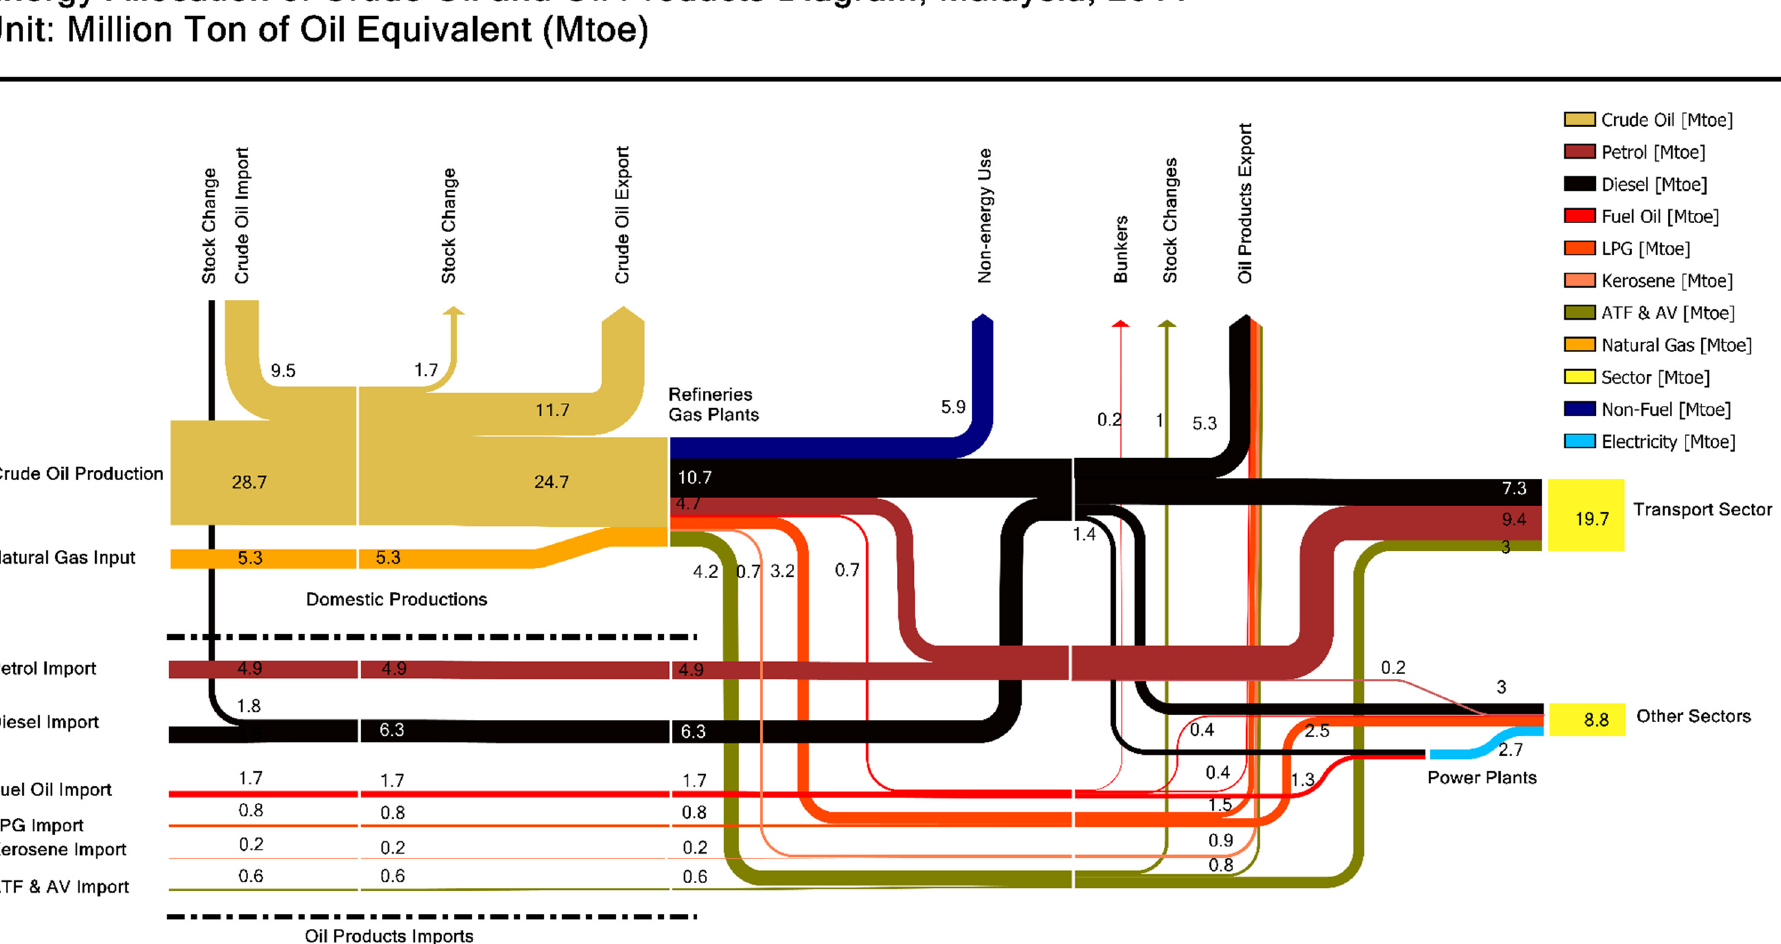
Figure 3. Malaysia energy allocation of crude oil and oil products diagram in